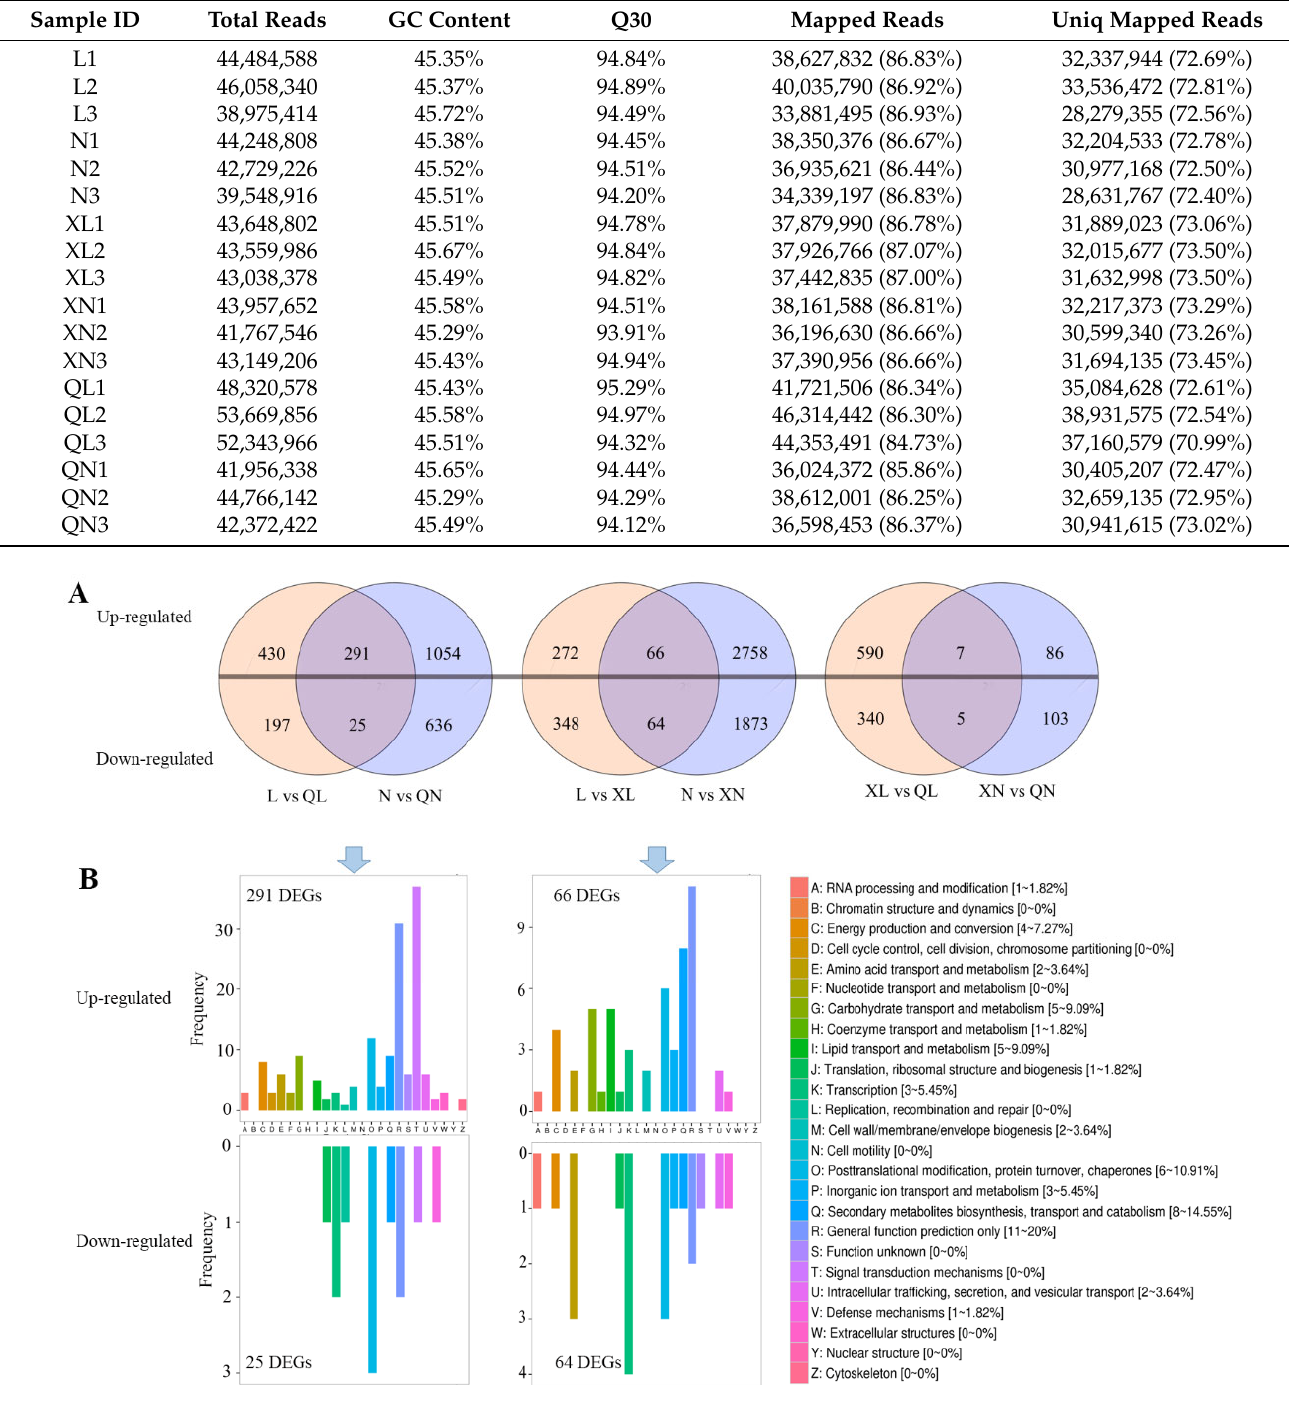
Figure 2. Differential expressed genes of Changqing tea leaves during different seasons. ( A ), the Venn diagram of differential expressed genes during different seasons. ( B ), the KOG classification of com- mon differential expressed genes in the samples from two tea gardens between different seasons. N, XN, and QN mean samples from Nanhuyulu tea garden in spring, summer, and autumn, respectively. L, XL and QL mean samples from Litaishan tea garden in spring, summer, and autumn, respectively. QRT-PCR analysis revealed an expected result that the relative expression patterns of DEGs during different seasons were consistent with the RNA-Seq data (Figure